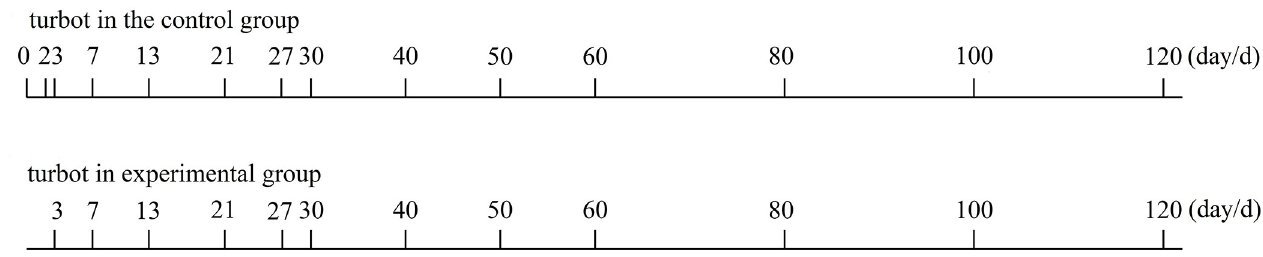
Fig 1. Sampling times for turbot larvae under the different treatments. The first feed for turbot larvae was started on day 3 and they fed on B . plicatilis processed in different treatments, whereas the samples on days 0 and 2 represented fertilized eggs and larvae without opening, respectively. Therefore, the first larvae samples in the experimental group were obtained on day